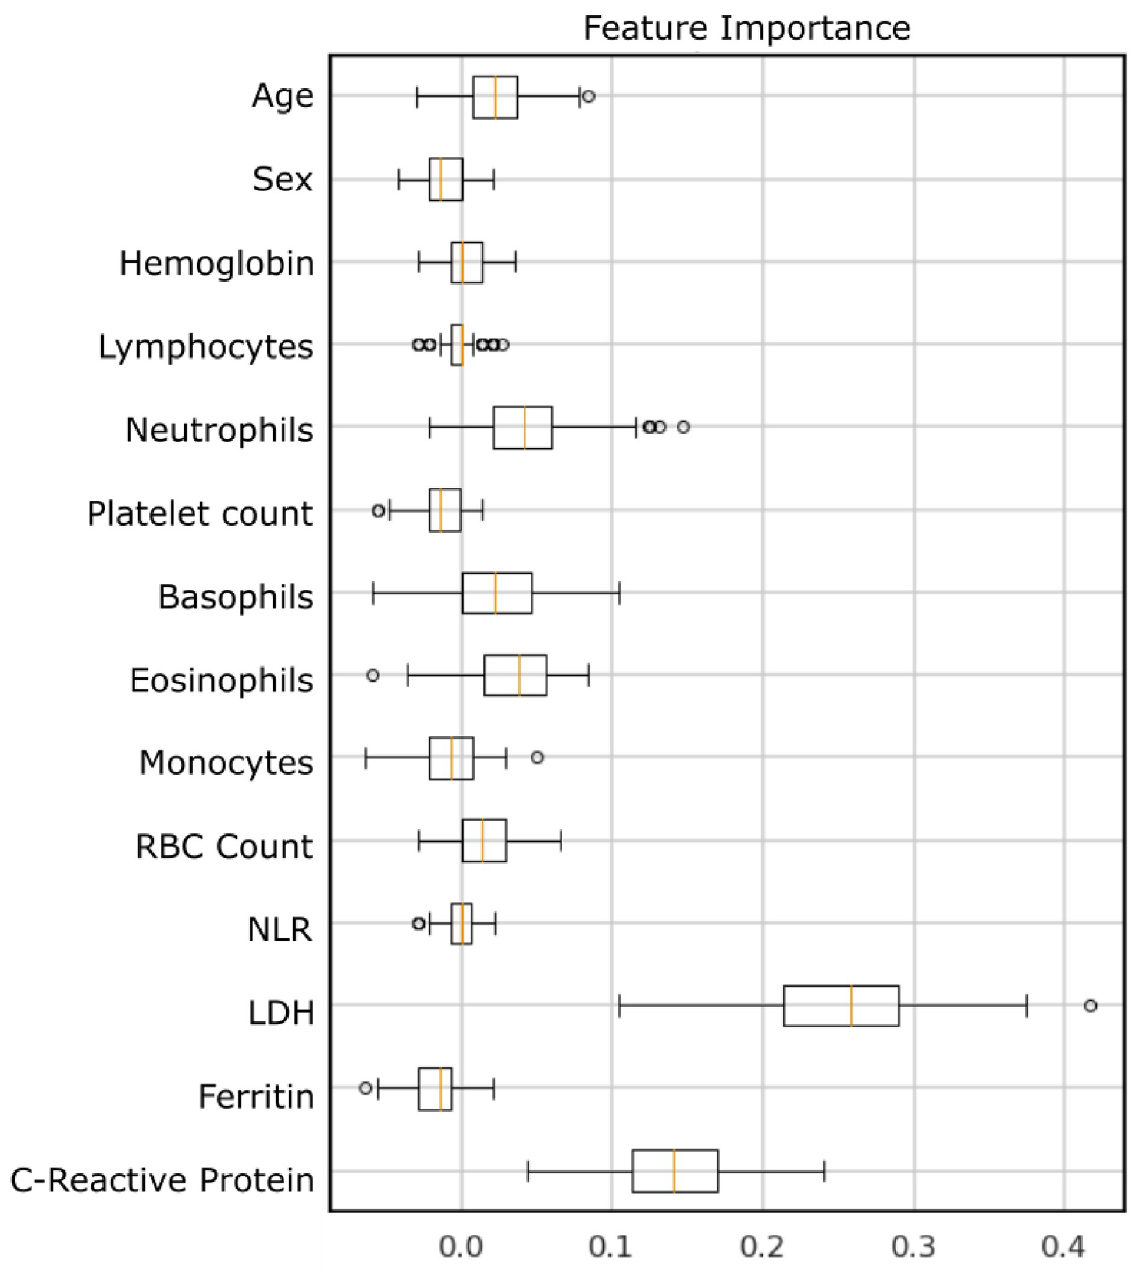
Fig 3. Combined model feature importance. Decrease in model performance (f1-score) after randomly shuffling the respective feature values. Higher values represent important features for classification. Abbreviations: LDH, lactate dehydrogenase; NLR, neutrophil to lymphocyte ratio; RBC, red blood